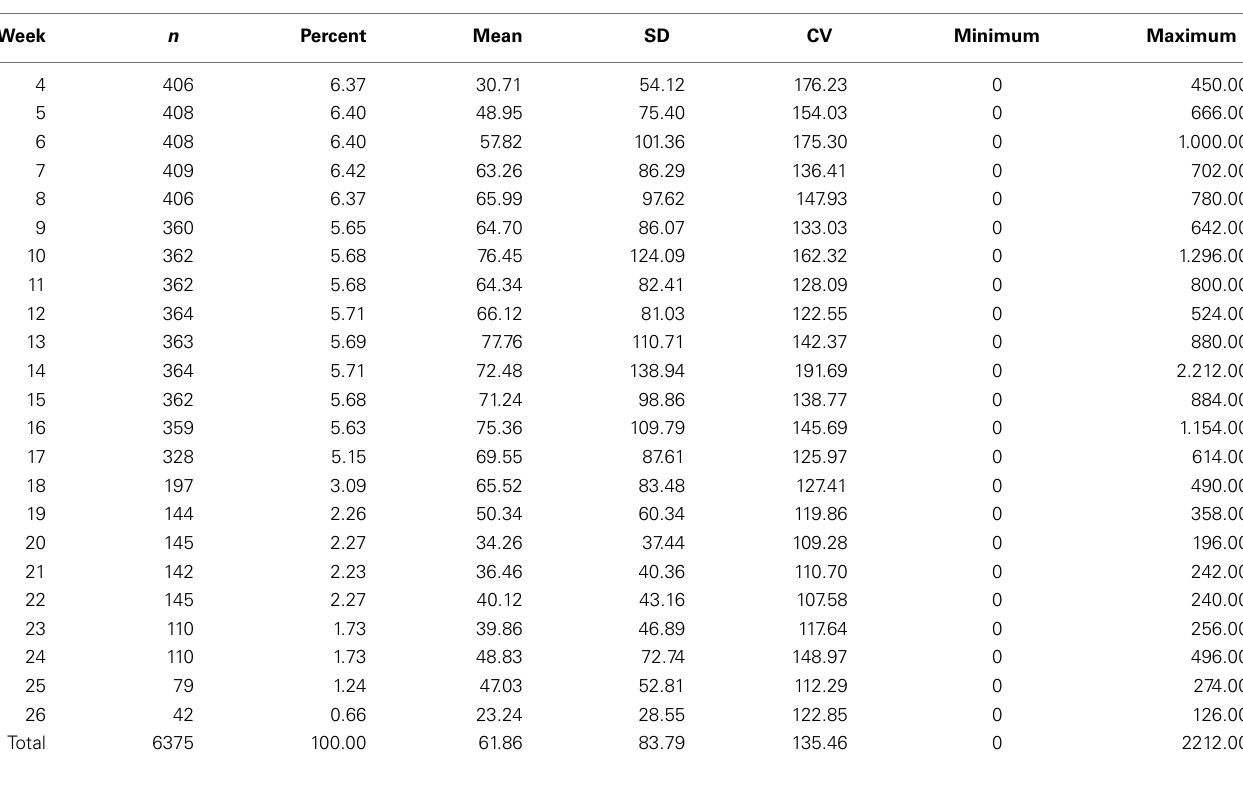
Table 1 | Descriptive statistics for fecal egg count (FEC) for weeks and overall data forAngus